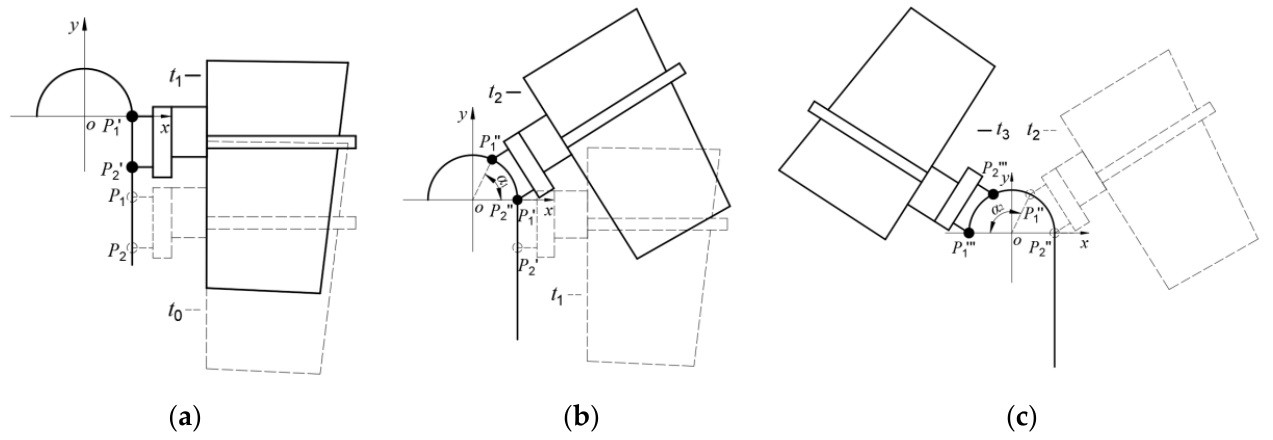
Figure 3. Three stages of the manipulator’s movement: ( a ) lifting movement; ( b ) transition movement; ( c ) turning movement. In the transition movement, the position of the manipulator is shown in Figure 4. In the figure, oxy is the world coordinate system; o 1 x 1 y 1 is the tool coordinate system; P (cid:48) is the 1 center point of the upper groove wheels; P (cid:48) is the center point of the lower groove wheels; 2 P (cid:48) is the equivalent center of mass of the manipulator and load; r 1 is the arc radius of the cm dumping track; l 1 is the center distance between the upper and lower groove wheels; l 2 is the distance between the point P (cid:48) and the y 1 axis; l 3 is the distance between the point P (cid:48) cm 2 and the y 1 axis; l 4 is the distance between the point P (cid:48) and the x 1 axis; α is the rotation cm angle of the manipulator; β is the pitch angle of the